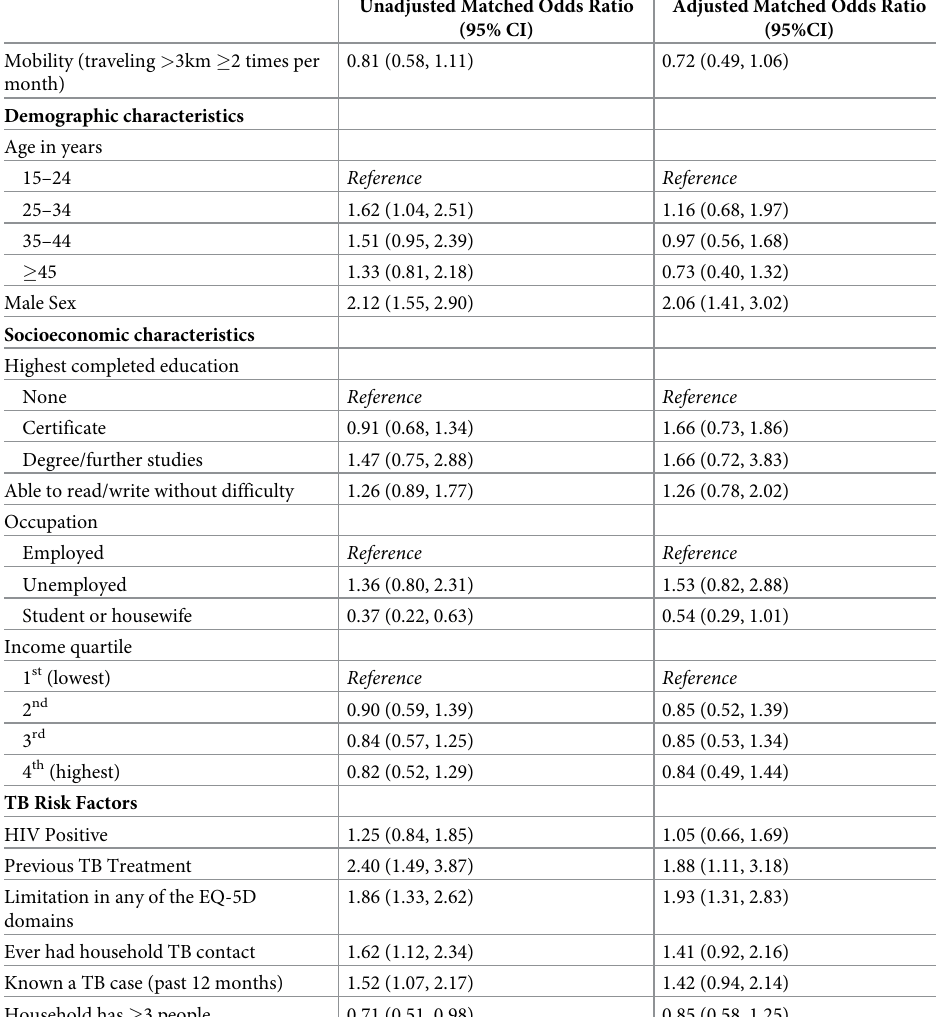
Table 4. Association of patient characteristics with TB case